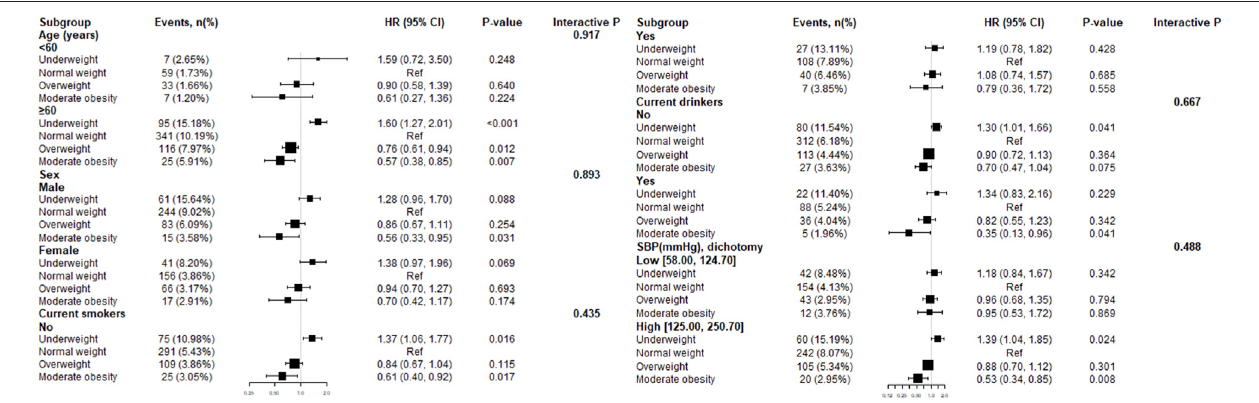
FIGURE 4 | Effect size of the different body mass index categories on all-cause mortality in prespeci fi ed and exploratory subgroups. Note: Each strati fi cation adjusted for age, sex, current smokers and drinkers, SBP and DBP except the subgroup variable. Abbreviations: Ref = reference; HR = hazard ratio; CI = con fi dence